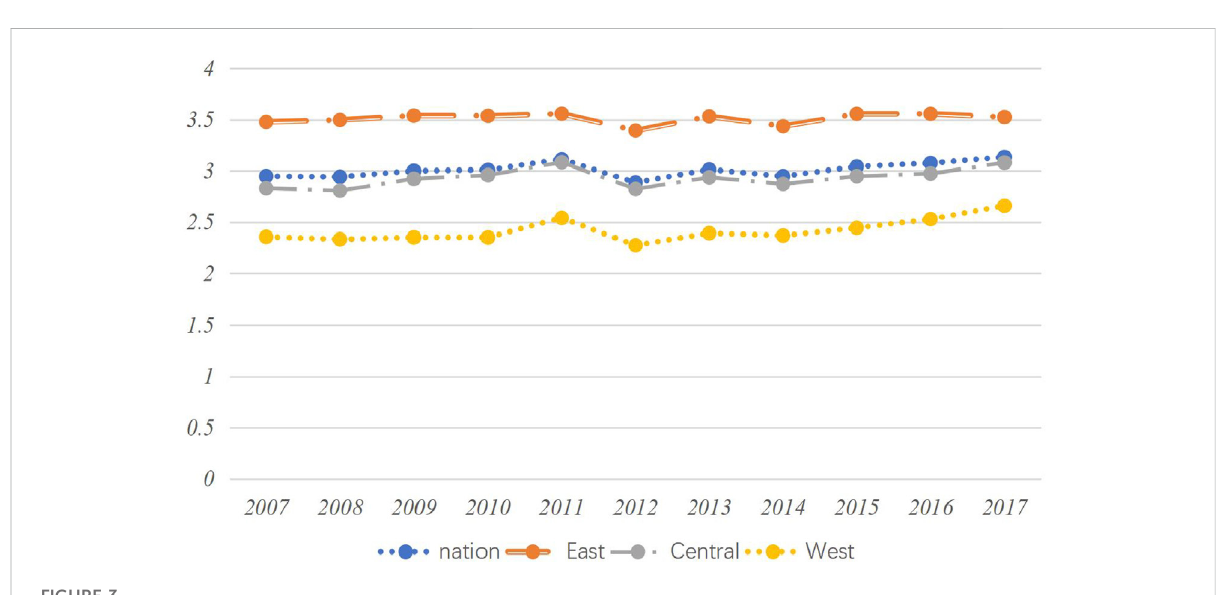
FIGURE 3 Development trend of industrial green